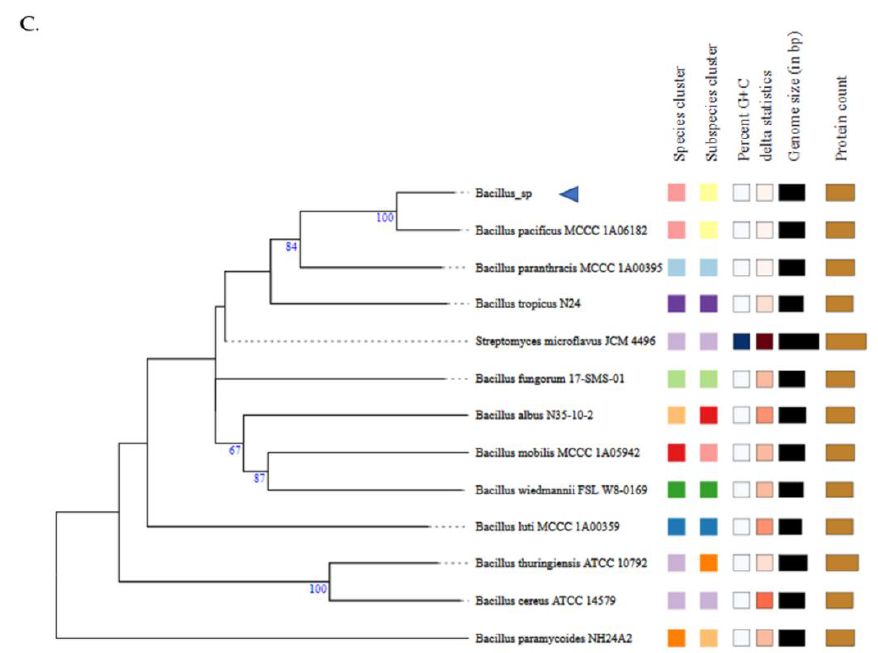
Figure 4. Phylogenetic analysis of Bacillus sp. B87. ( A ) The codon tree method selects single-copy PATRIC PGFams and analyzes aligned proteins and coding DNA from single-copy genes using the program RAxML. ( B , C ) TYGS results of Bacillus sp. B87 based on 16S rRNA gene ( B ) and whole-genome ( C ) sequences.